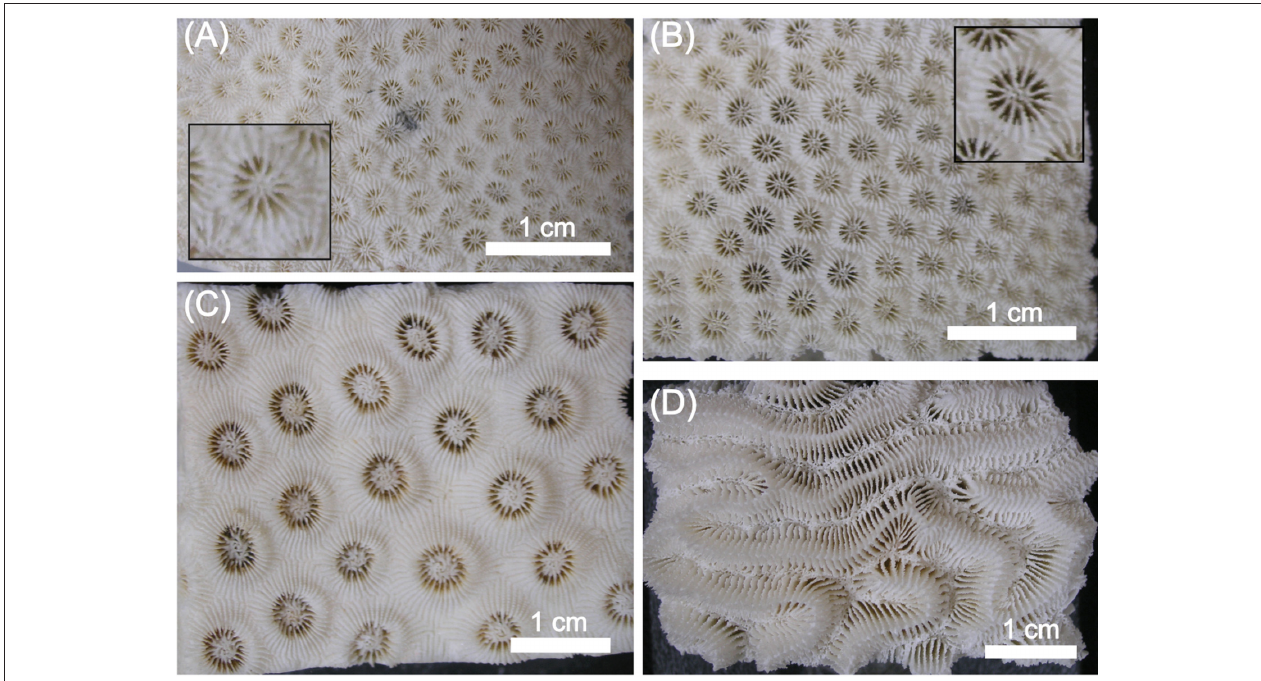
FIGURE 1 | Images of coral skeletons for (A) Orbicella annularis , (B) Orbicella faveolata , (C) Montastraea cavernosa , and (D) Pseudodiploria strigosa . The inserts in (A,B) show a close-up of the calyx structure of O. annularis and O. faveolata , respectively. The scale bar in each panel is 1 cm.